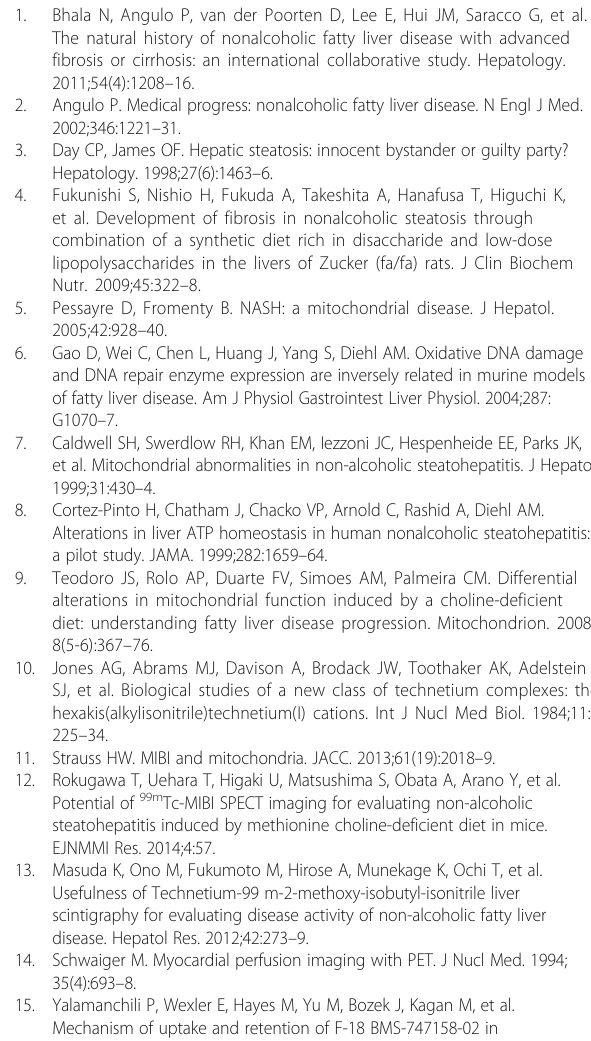
Fig. 6 Correlation between hepatic 18 F-BMS uptake and mitochondrial complex 1 (MC-1) activity in mice fed control and MCD diet. Correlation analysis using the Pearson product-moment